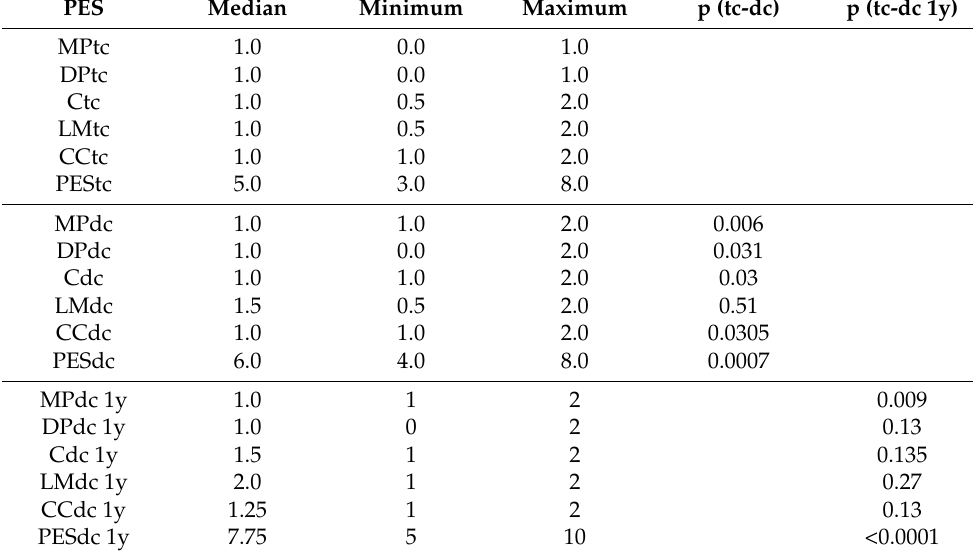
Table 3. Pink aesthetic score at relevant stages of study. Table 4. Papilla index at relevant stages of study.